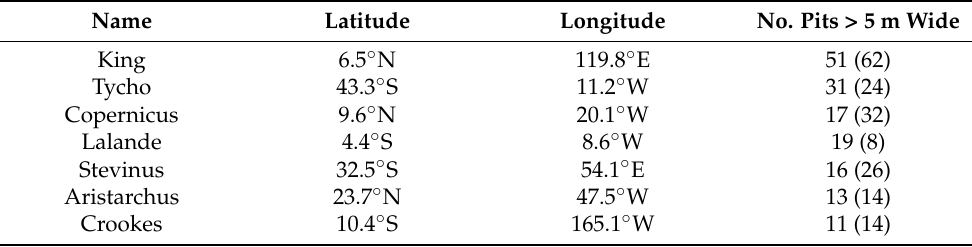
Table 1. Seven craters containing more than ten pits